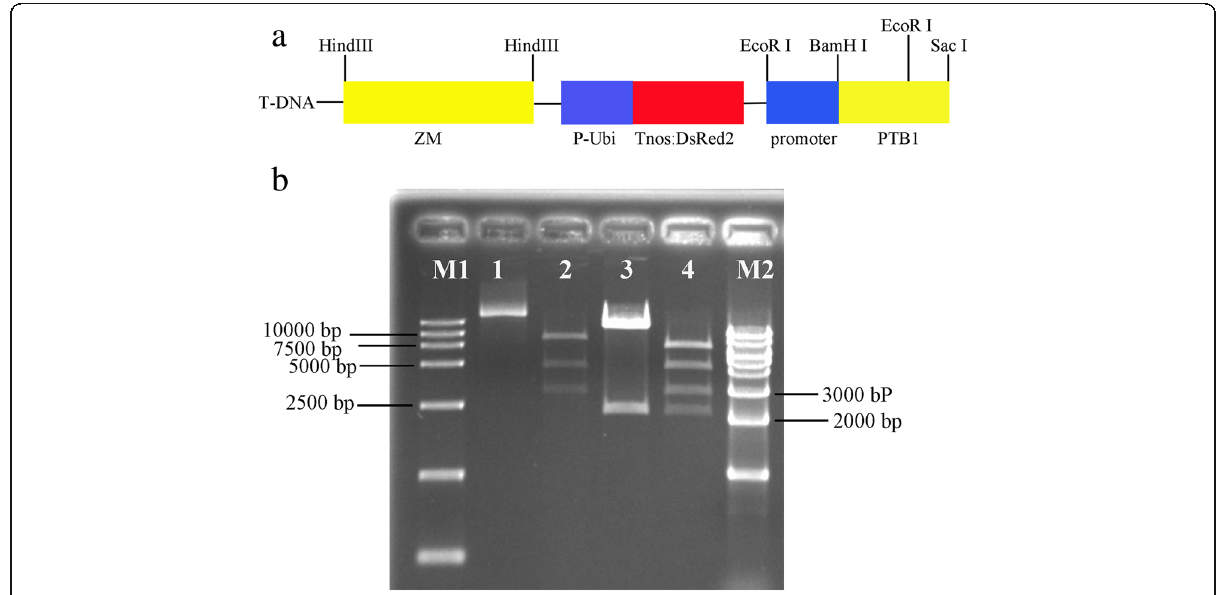
Fig. 1 Construction of the pFS4 vector. a Three expression cassettes in the T-DNA. Pollen lethal gene cassette was about 4.7 Kb; the